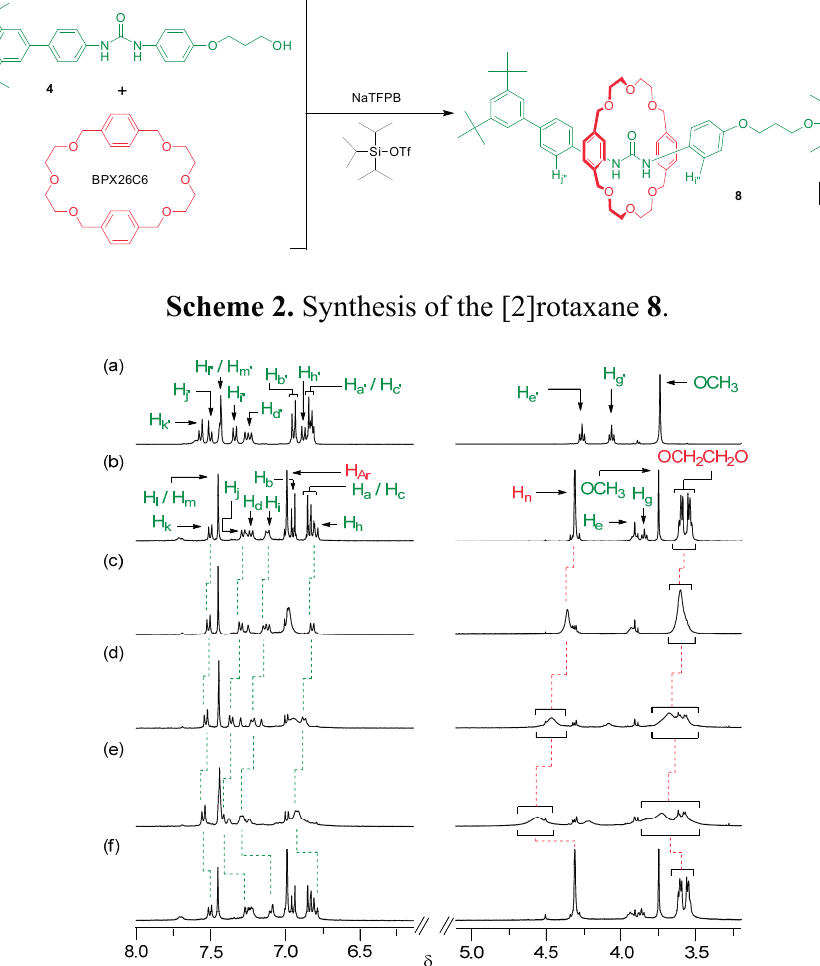
Figure 2. 1 H-NMR spectra (400 MHz, CD 3 CN, 298 K) of ( a ) the dumbbell-shaped molecule 7 , ( b ) the [2]rotaxane 1 , and ( c – f ) the solutions obtained after additions of (c) 0.5, (d) 1.0, and (e) 1.5 equiv of NOBF 4 to the solution in (b) and (f) excess Zn powder to the solution in